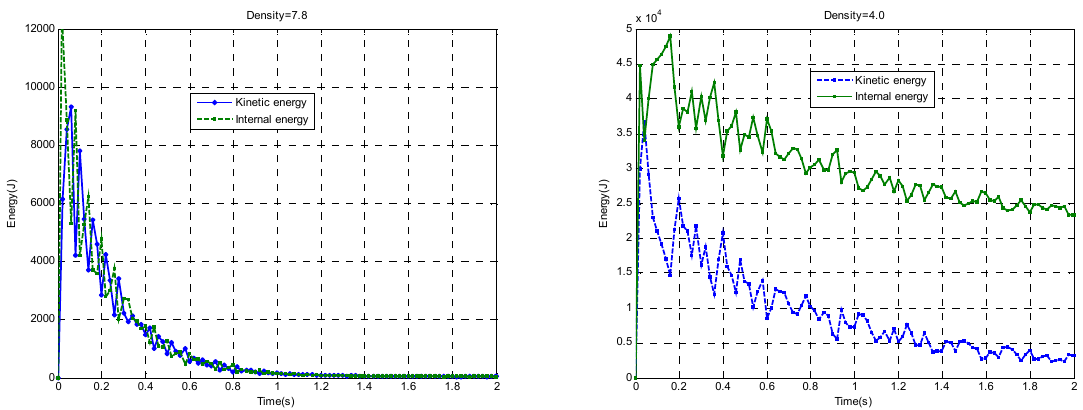
Table 6. Plastic kinematic model, E = 210 GPa,